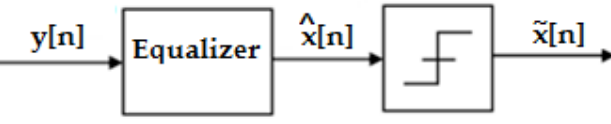
Figure 2. The decision block is preceded by an equalizer.